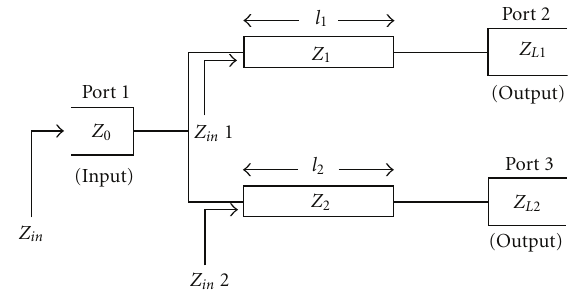
Figure 1: Schematic of a single-feed switchable feed network.